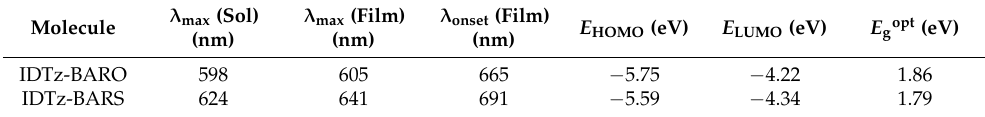
Figure 1. ( a ) Optical absorption spectra of IDTz-BARS and IDTz-BARO films spin-coated from chloroform solutions (10 − 3 M). ( b ) CV curves of acceptors IDTz-BARS and IDTz-BARO. ( c ) Energy levels of IDTz-BARS and IDTz-BARO. Table 1. Optical absorption properties and electrochemical properties of IDTz-BARS and